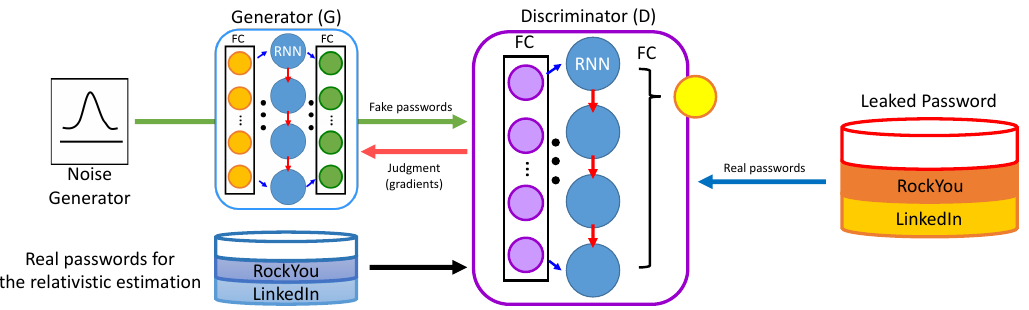
Figure 2. REDPACK Training Phase Diagram.